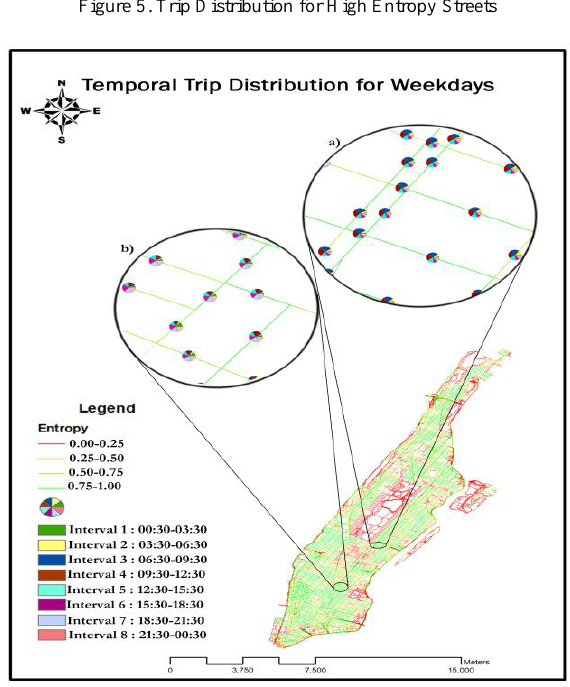
Figure 6 . Trip Distribution for a) Employment and Commercial, and b) Residential Areas, in Each Time Window for High Entropy